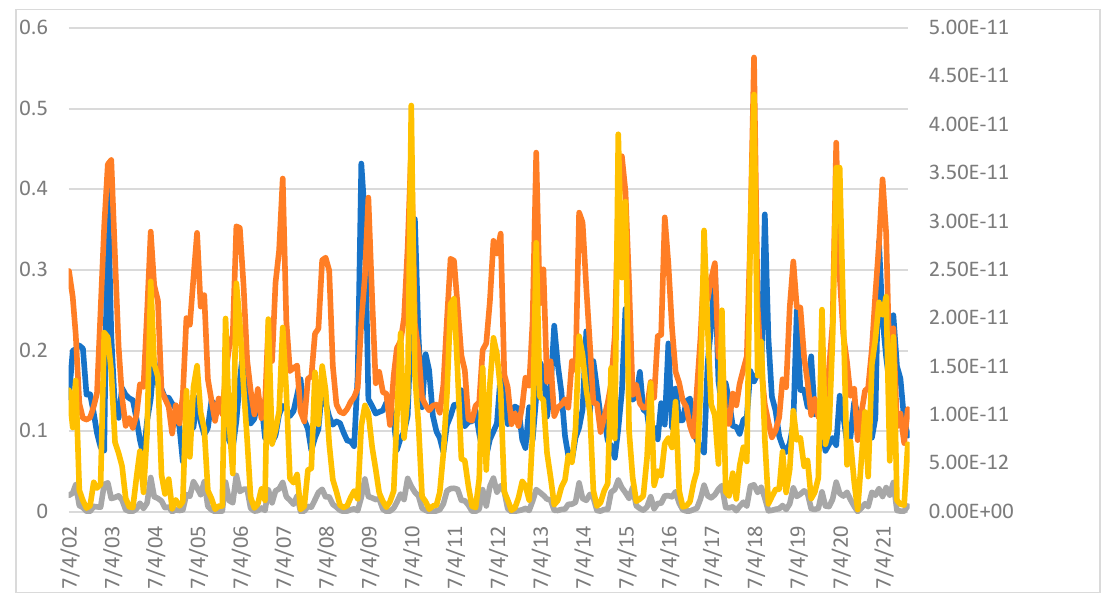
Figure 8. Time series data obtained from Giovanni (Blue—Chlorophyll MODIS-A, Orange—AOD MODIS, Grey—MERRA II Dry deposition, yellow—MERRA II Wet deposition).